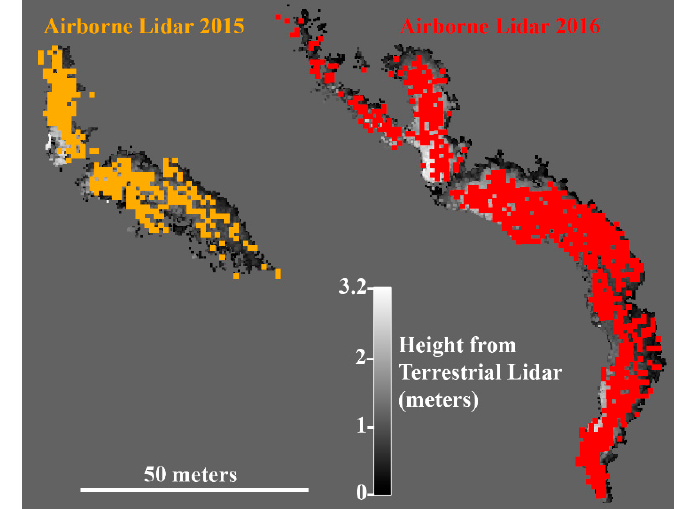
Figure 11. Phragmites australis extent derived from airborne lidar acquisitions in 2015 (left, orange) and 2016 (right, red). Terrestrial lidar representations of Phragmites australis from 2015 (left) and 2016 (right) are co-located with airborne representations, and colored by height.